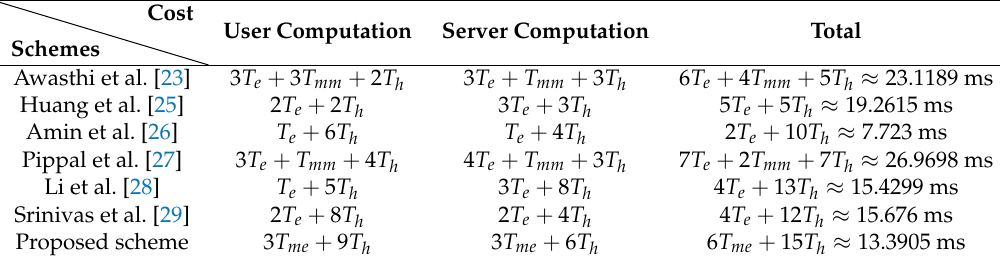
Table 6. Comparison of computational